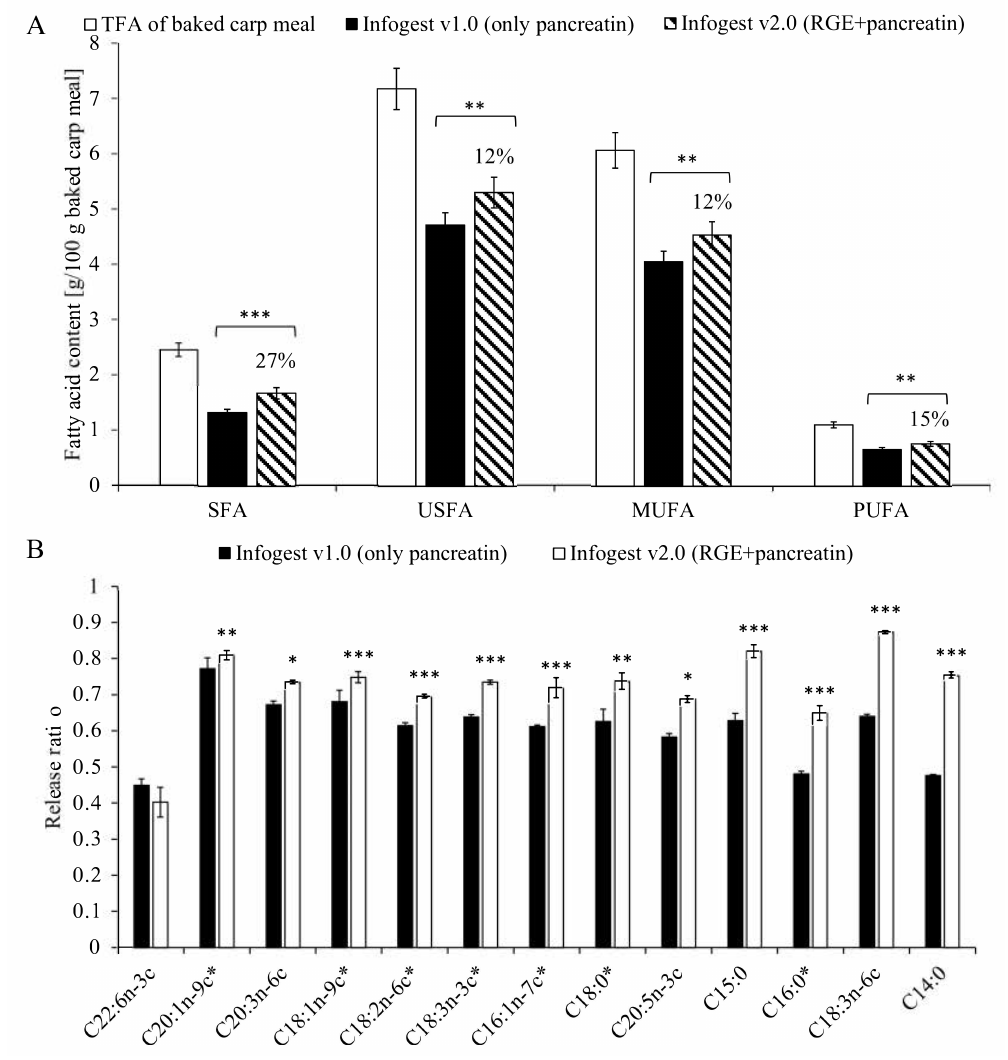
Figure 2. ( A ): Saturated fatty acid content (SFA), unsaturated fatty acid content (USFA), monounsaturated fatty acid content (MUFA), and polyunsaturated fatty acid content (PUFA) of a baked carp meal expressed as g/100 g baked carp meal. Total fatty acid content (TFA) was determined from small intestinal digesta via the TFA method (blank column), and the released fatty acid content after Infogest v1.0 (black column) and Infogest v2.0 (hatched column) was calculated as given in Equation (1). The difference between the released FA composition via v1.0 and v2.0 is given in % above the respective columns. ( B ): Release ratio (RR) of individual fatty acids in the baked carp meal (Equation (2)). Asterisks following FA abbreviations show FAs occurring at >1 w/w% in the sample. Comparison between Infogest v1.0 (black column) and v2.0 (blank column). Significance determined via the t test shown: *: p < 0.05; **: p < 0.01; ***: p < 0.001. RGE: rabbit gastric